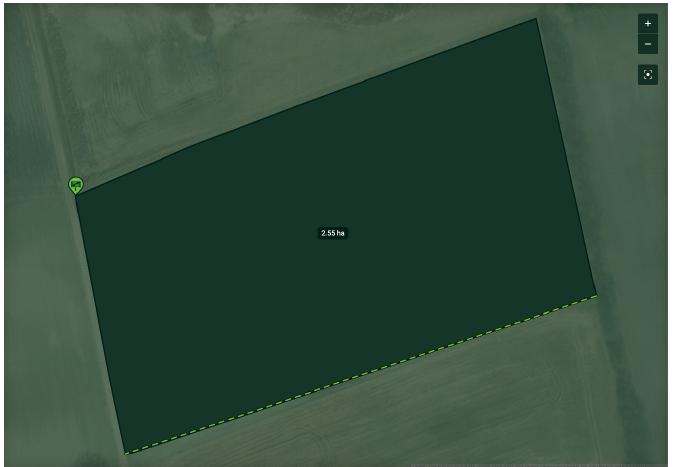
Figure 1. Example field, showing the field boundary, size, access points (round marker) and crop row direction (dotted